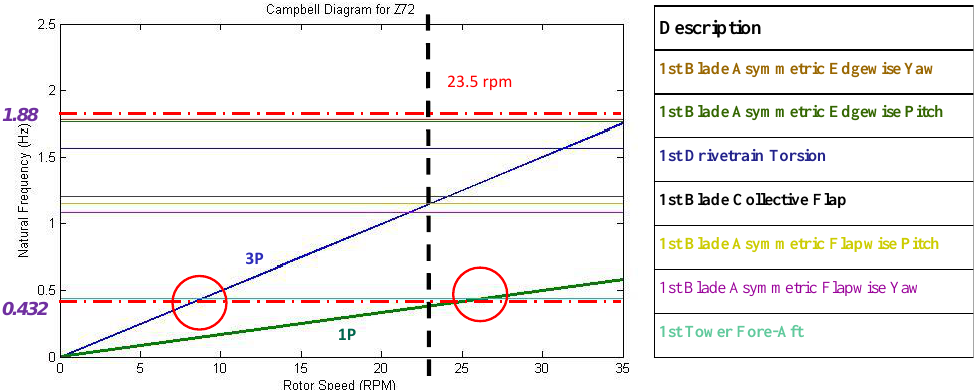
Figure 18. Campbell diagram of 2 MW wind turbine.